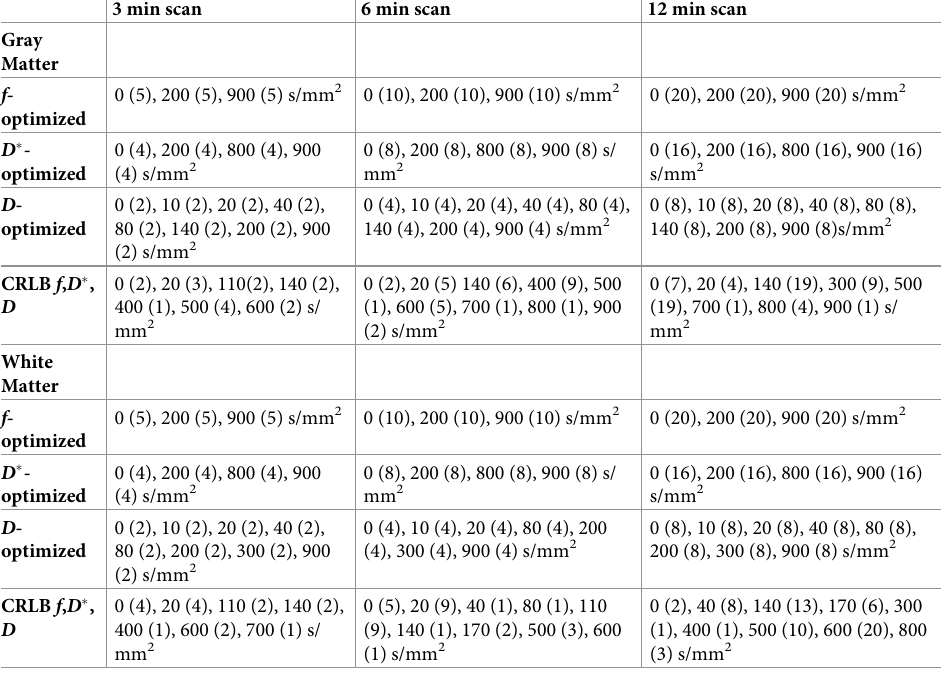
Suggested optimized b value sets for IVIM in the brain (number of averages in parenthesis), for 3 minutes, 6